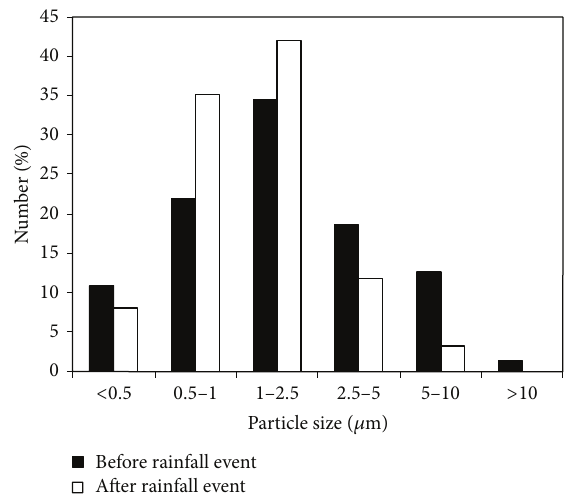
Figure 7: The particle size distribution before and after a rainfall